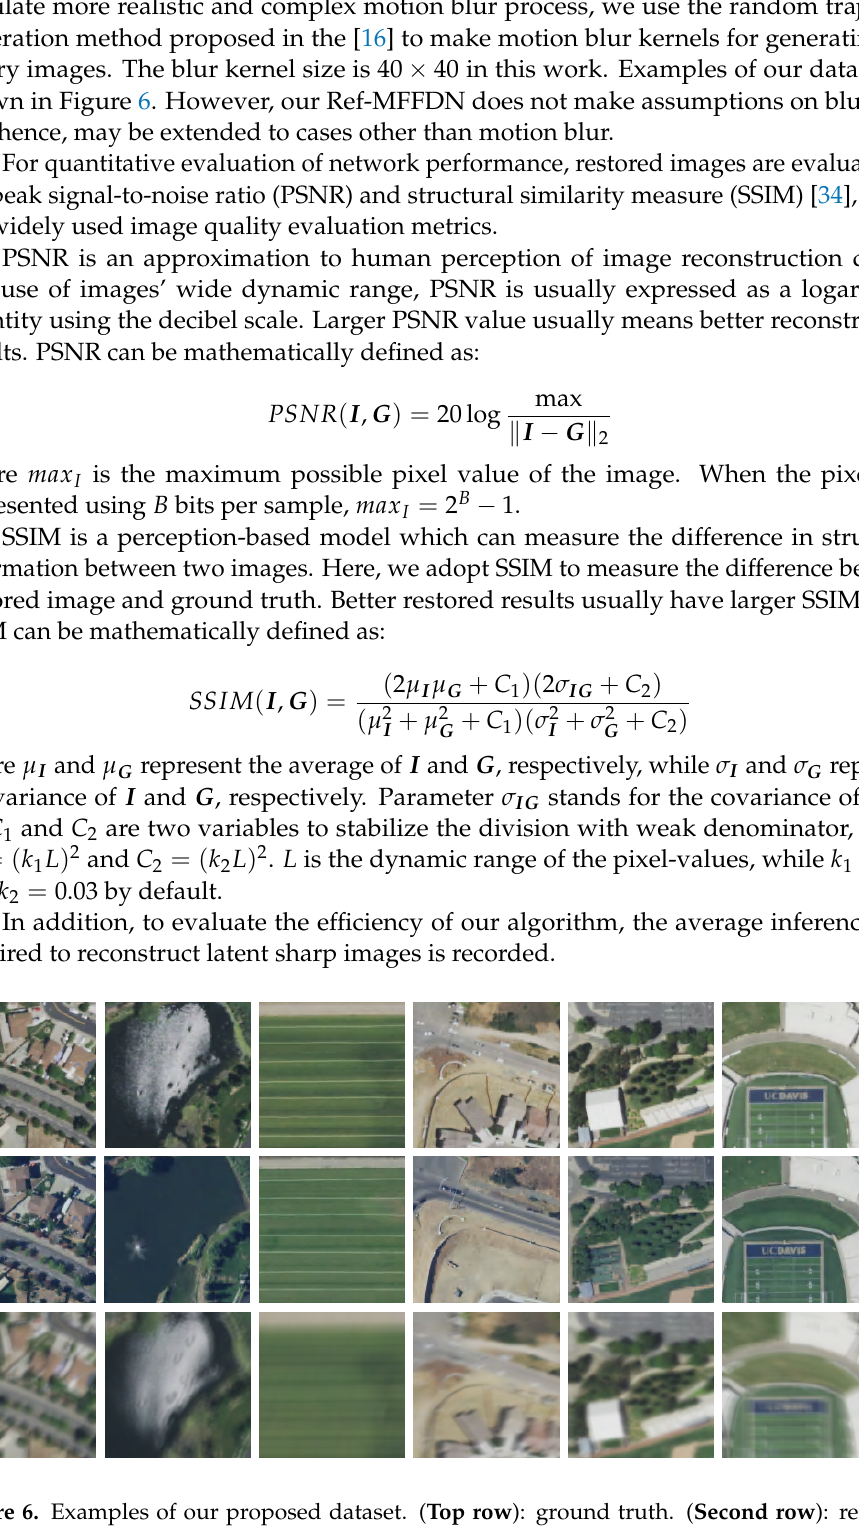
Figure 6. Examples of our proposed dataset. ( Top row ): ground truth. ( Second row ): reference image. ( Bottom row ): blurry